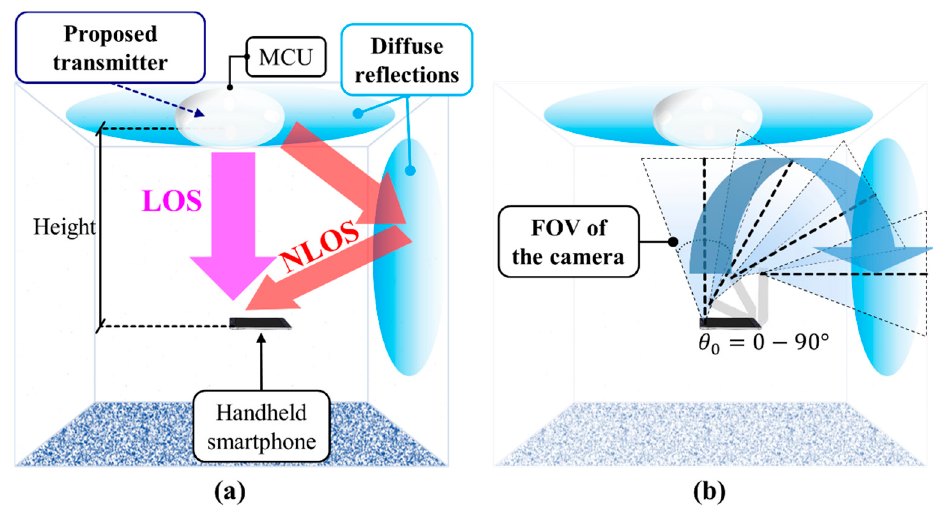
Figure 24. Wide RX orientation scheme: ( a ) providing both LOS and NLOS communication links; ( b ) wide RX orientation.